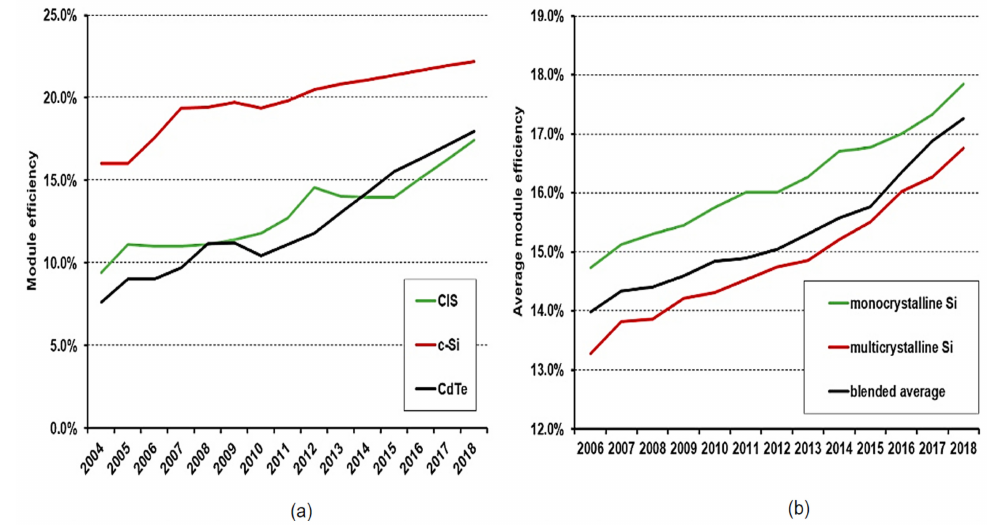
Figure 2. ( a ) Development in efficiency for the top products on the market. ( b ) Development of average efficiency in crystalline silicon modules